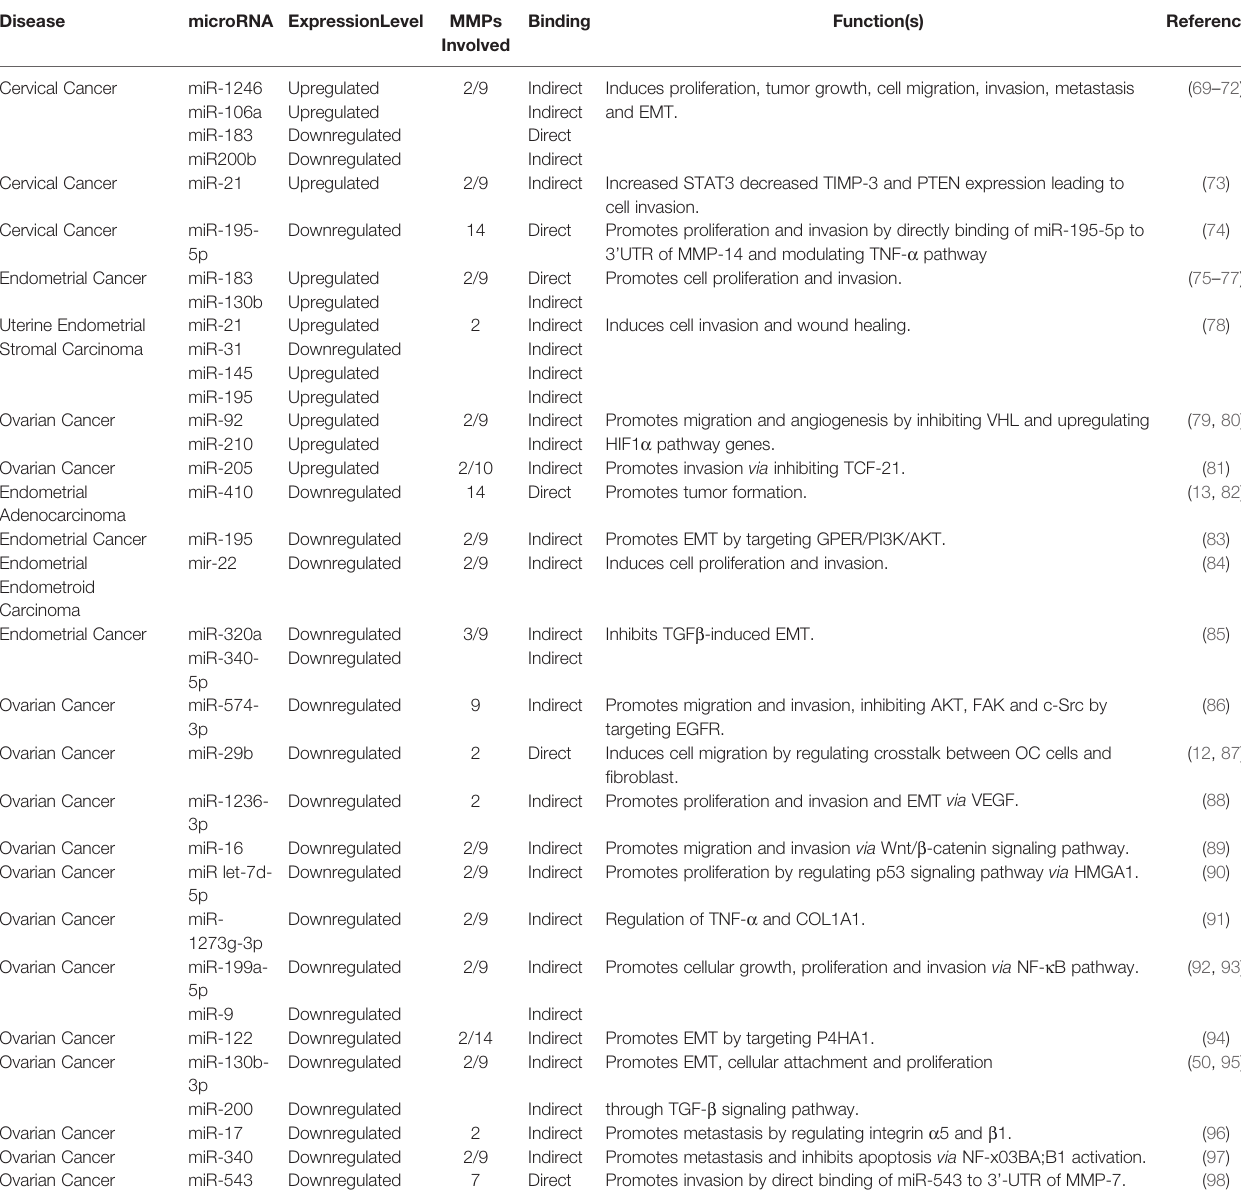
TABLE 1 | Oncogenic and tumor suppressor miRNAs regulating MMPs during development of gynecological cancers. Disease microRNA ExpressionLevel MMPs Involved